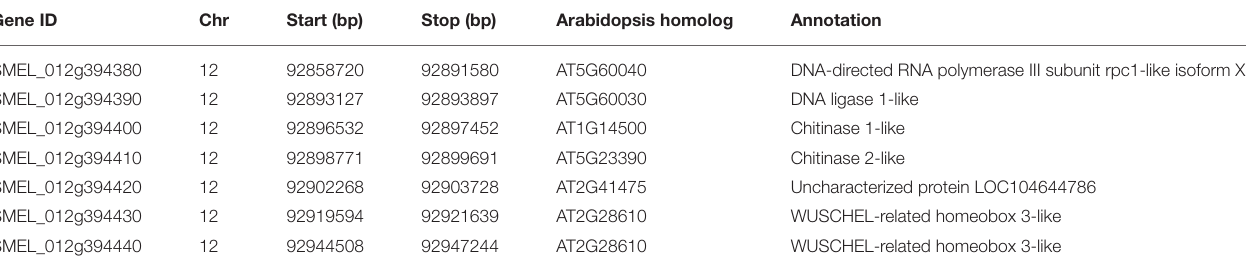
TABLE 2 | Genes in the region of the QTL for the prickle numbers on the